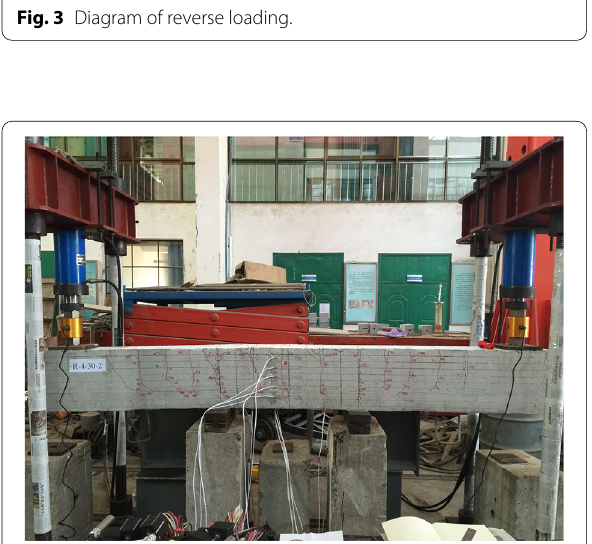
Fig. 4 Actual RC beams with 600 MPa steel bars and test